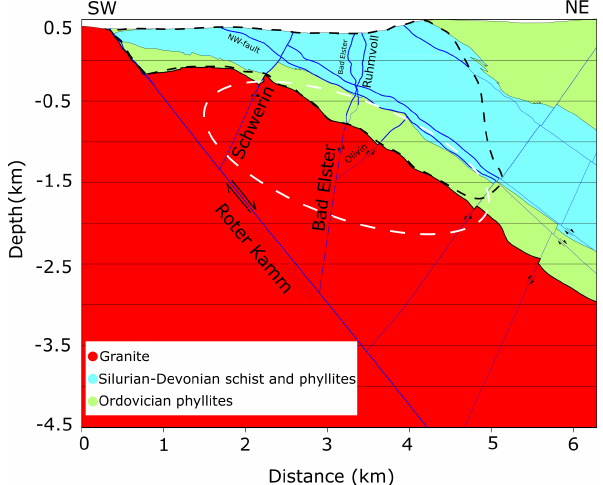
Figure 2. Vertical profile of the investigation area developed by Wallner et al. (2009). The dashed black line shows the approxi- mate border of the mining area, and the white ellipse shows the area where the hypocentres used in this study are located. For sim- plification, not all of the known faults are depicted in this